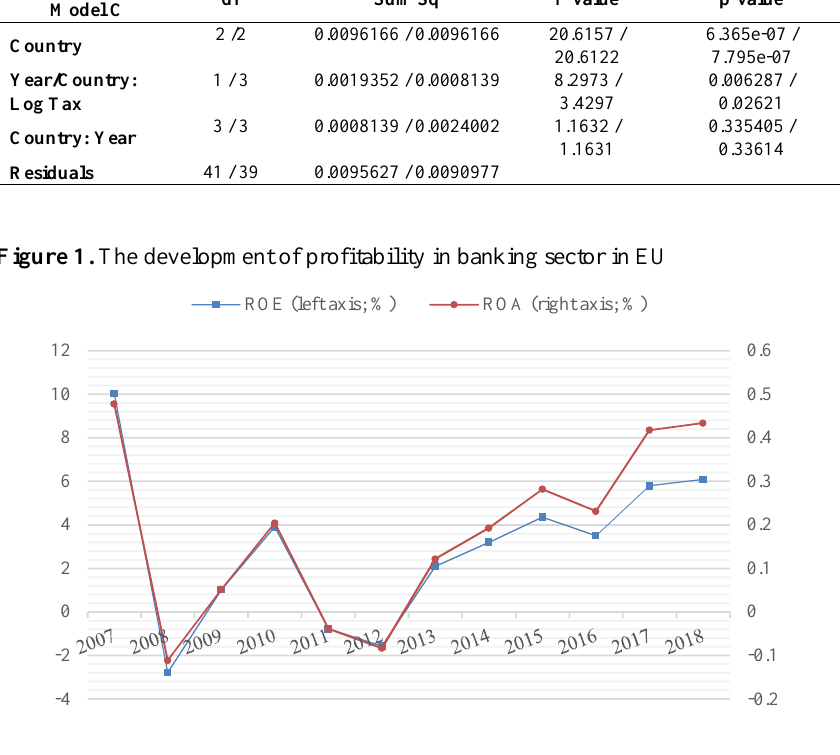
Source: own calculation based on ECB Statistical Data Warehouse